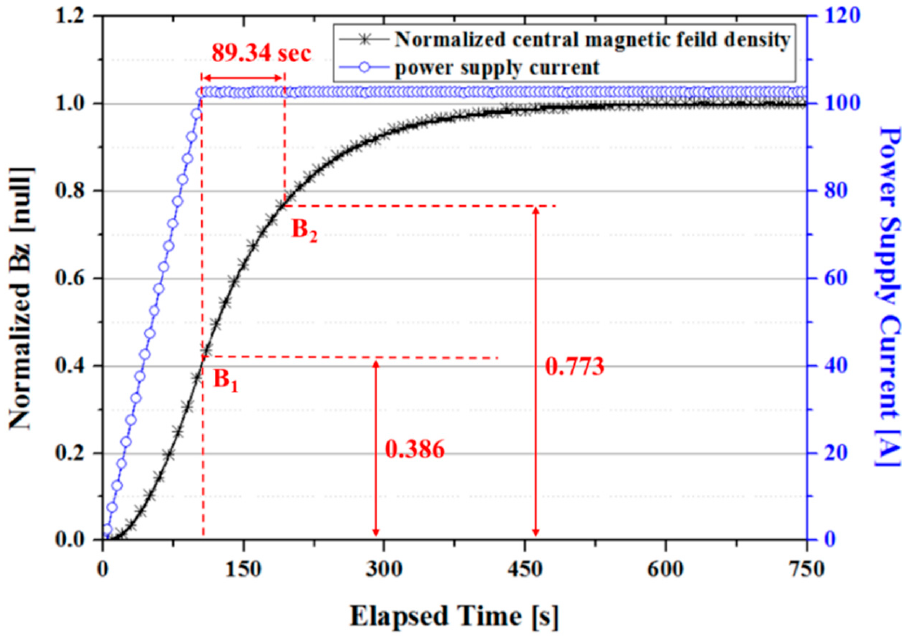
Figure 7. Charging test result of the fabricated NI HTS field coil.